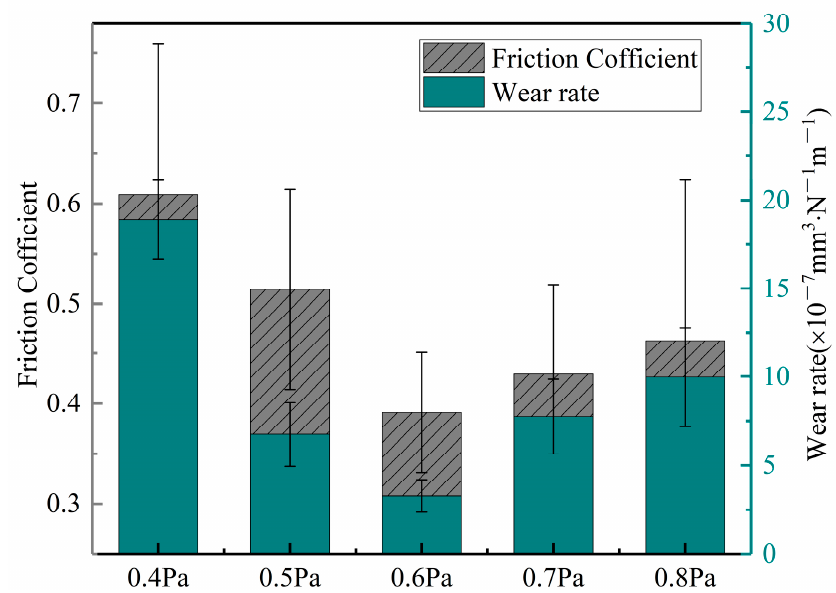
Figure 5. Friction coefficients and wear ratios of the coatings deposited at different pressures.